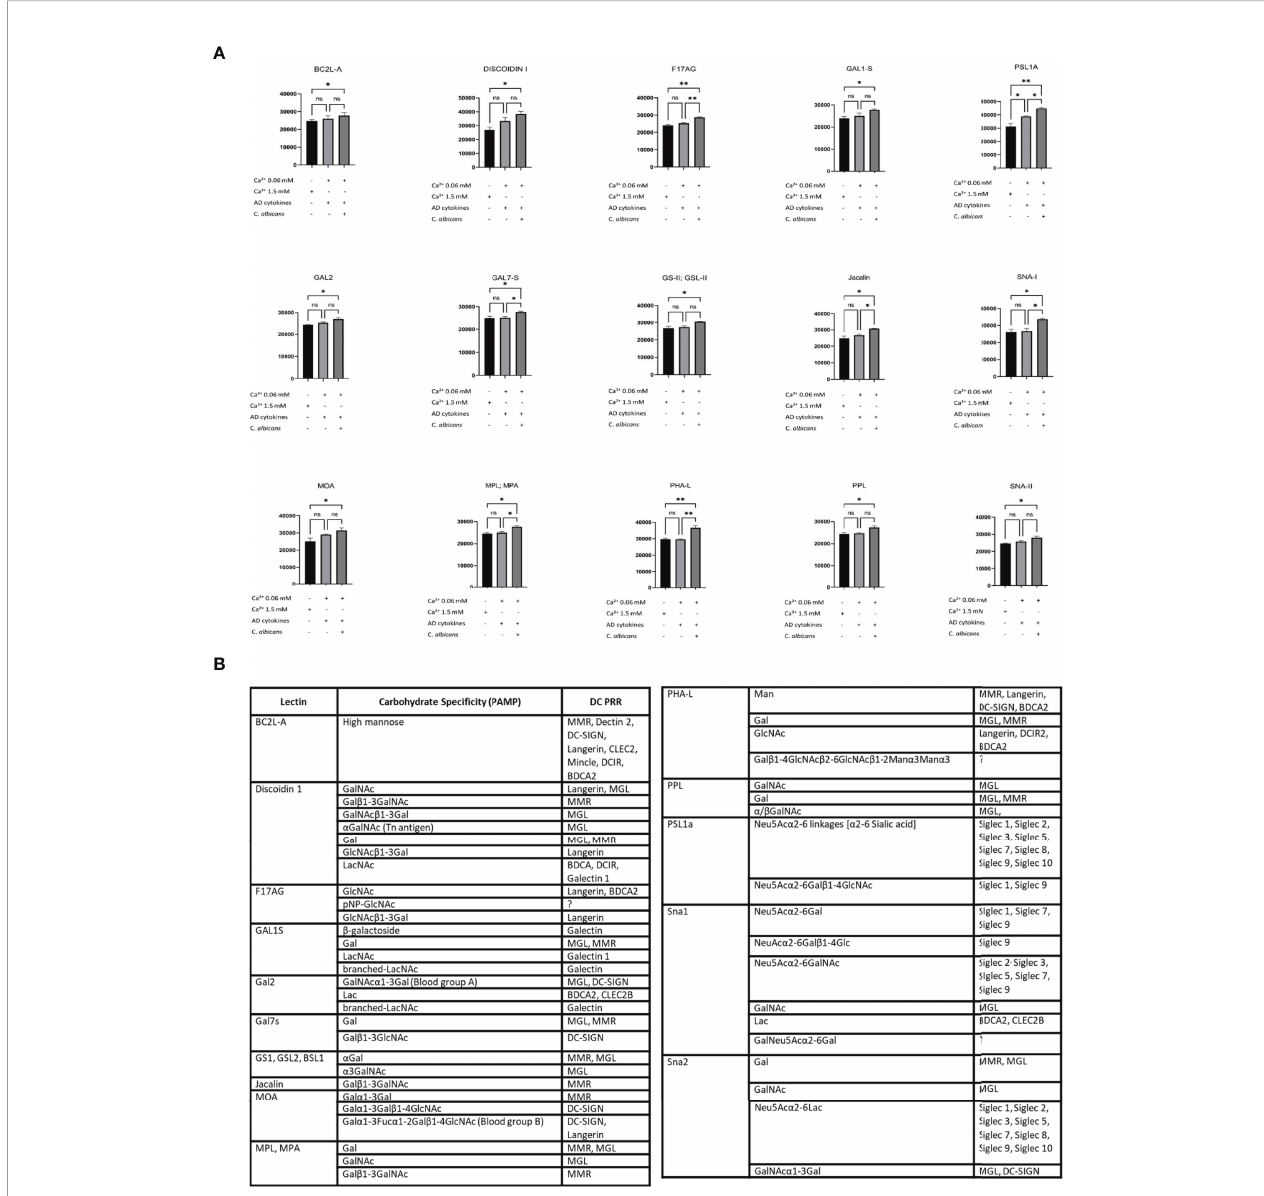
FIGURE 5 | Lectin array-based identi fi cation of carbohydrate moieties on the adhesive sEV NHEK map to potential receptors on antigen presenting cells. (A) Lectin binding to carbohydrate moieties on the surface of sEV NHEK ; data summarizes biological duplicates with n=3 keratinocyte donors; *p < 0.05; **p < 0.01; (B) carbohydrate moieties enriched in the more adhesive sEVs as identi fi ed by lectin array, together with potential binding receptors on antigen presenting cells as identi fi ed by the literature search (full list, including references in Table S4 ). ns, not signi fi